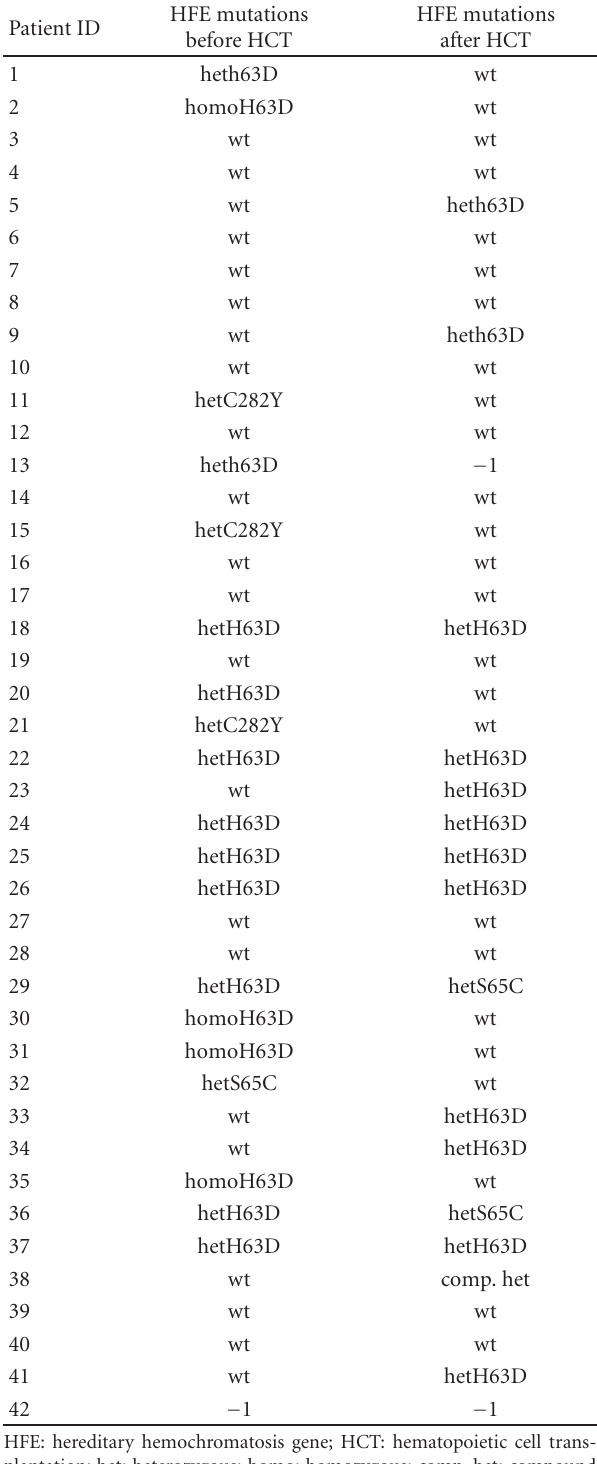
Table 2: HFE mutations before and after allogeneic HCT. Patient